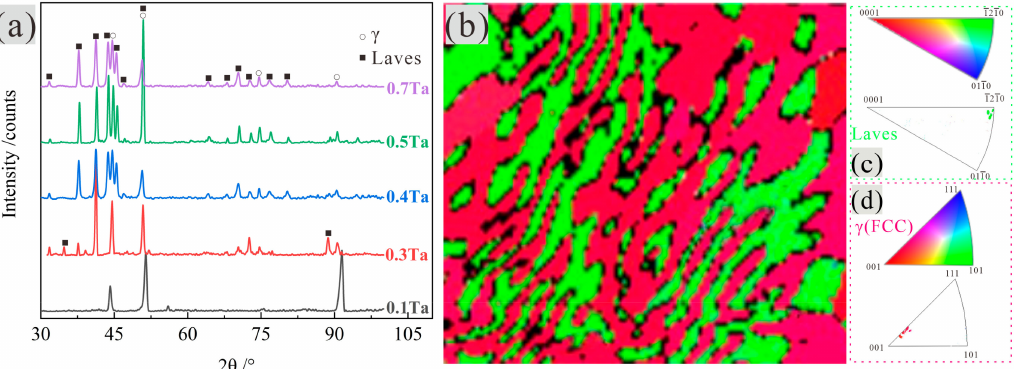
Figure 3. ( a ) XRD patterns of as-cast CrCoNiTa x alloys. ( b ) EBSD mapping of CrCoNiTa 0.4 alloy. The γ (FCC) and Laves (HCP) phases. The corresponding EBSD inverse pole figure of ( c ) Laves phase and ( d ) γ